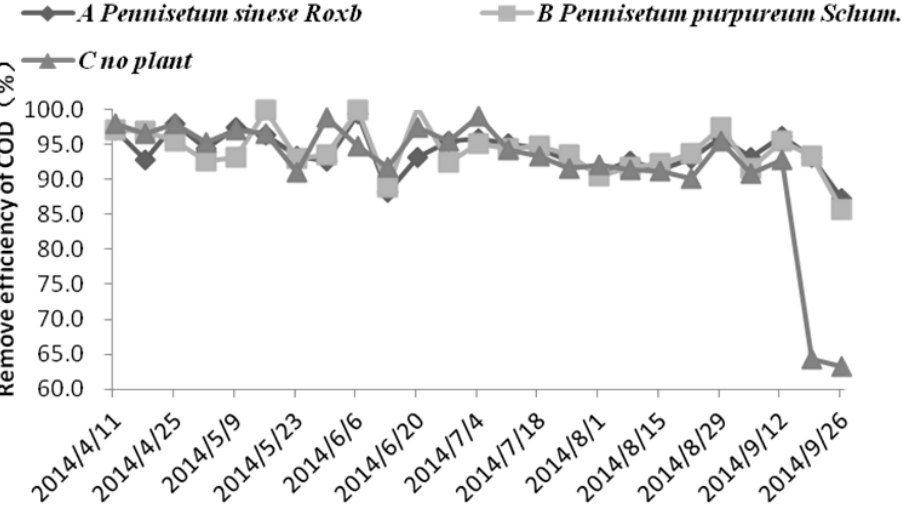
Figure 2. Removal efficiency of COD in three systems.